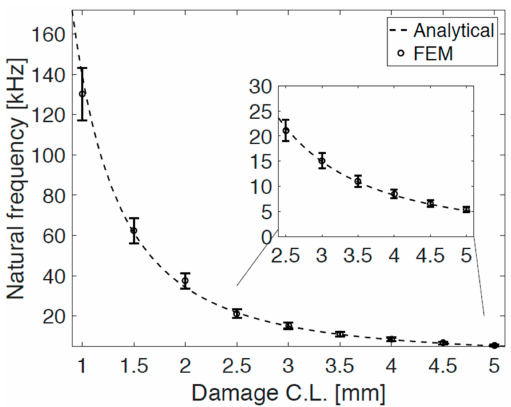
Figure 10. Analytical results (see Equation (1)) and FEM